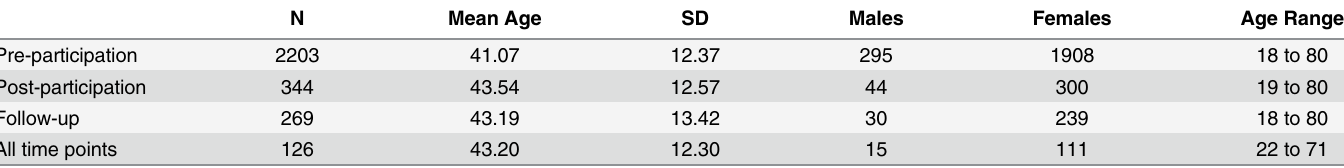
Table 1. Participant ages and gender by time